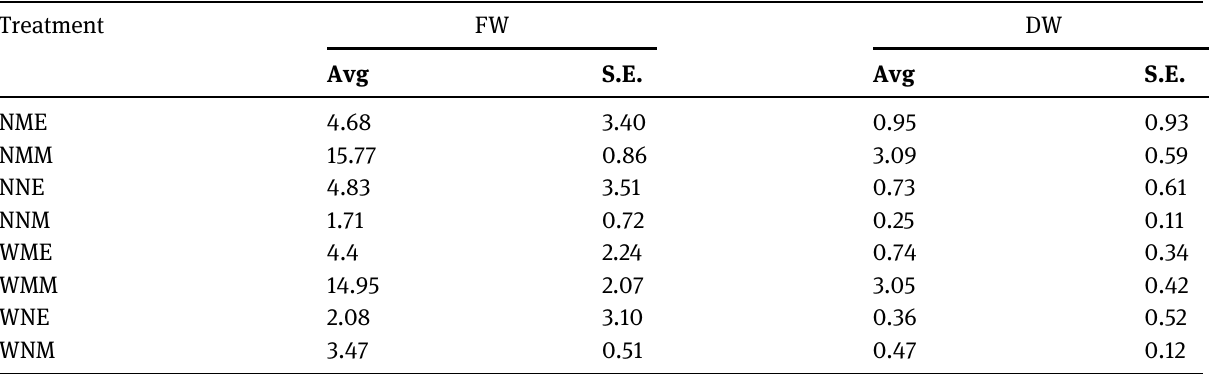
Table 3: Average FW and DW of the aboveground biomass of Rucola. Treatment